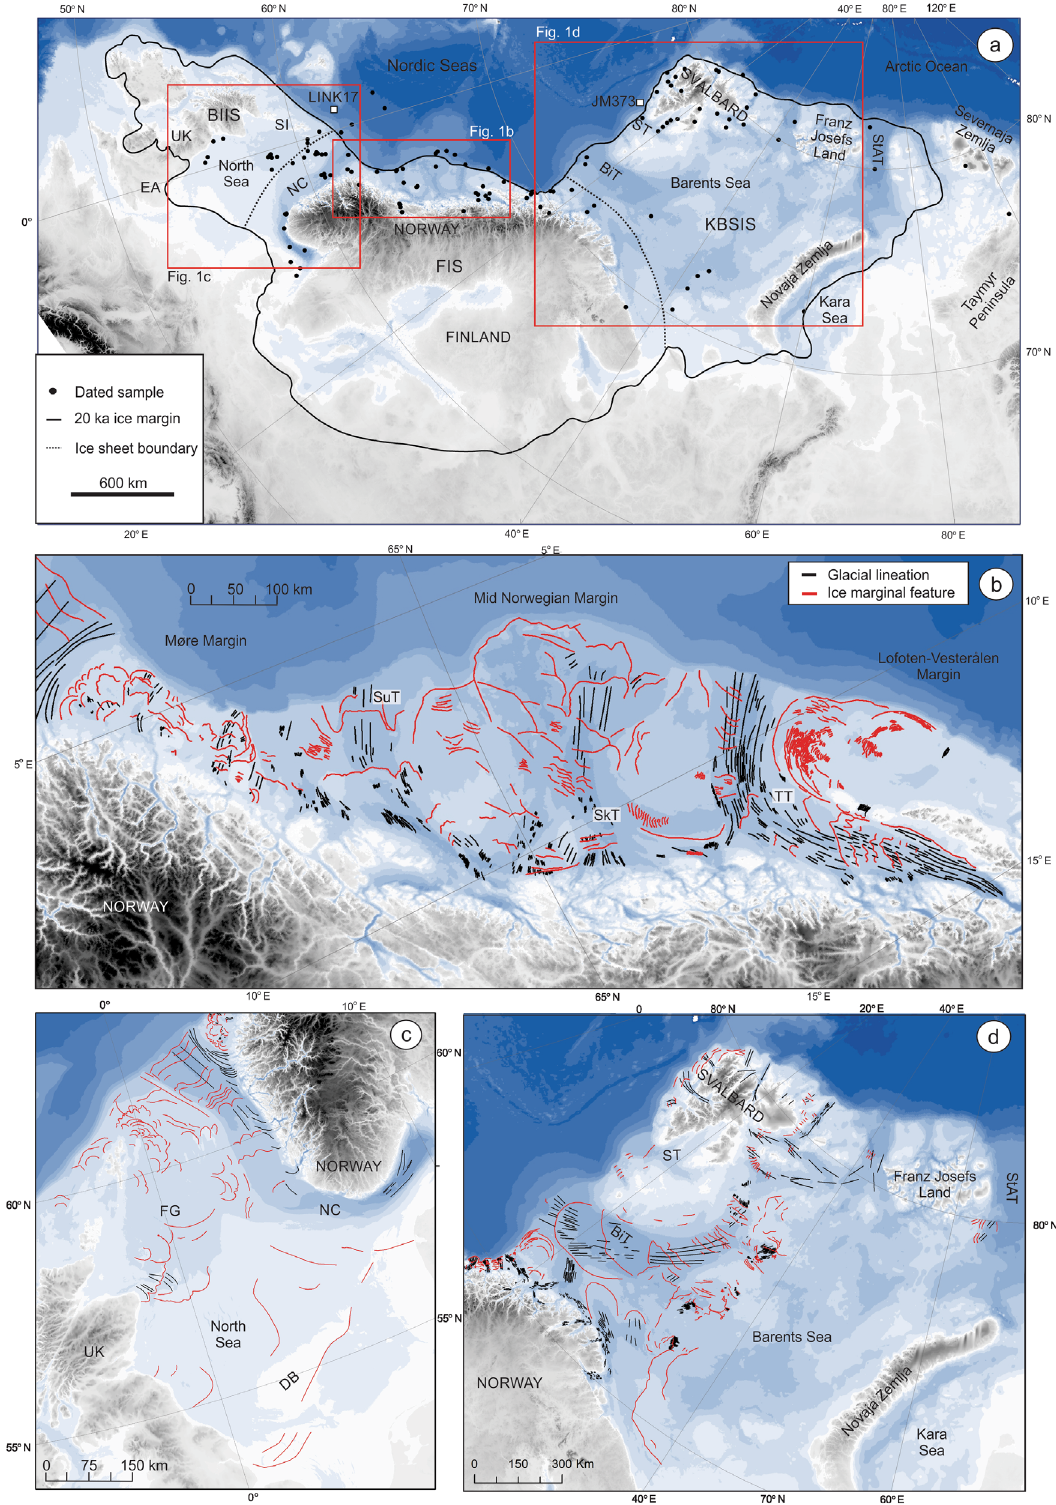
evidenced 27,28 . In contrast, considerable uncertainty remains pattern along the eastern margin of the KBSIS, re fl ecting sparse geological and chronological datasets in the Russian sector.